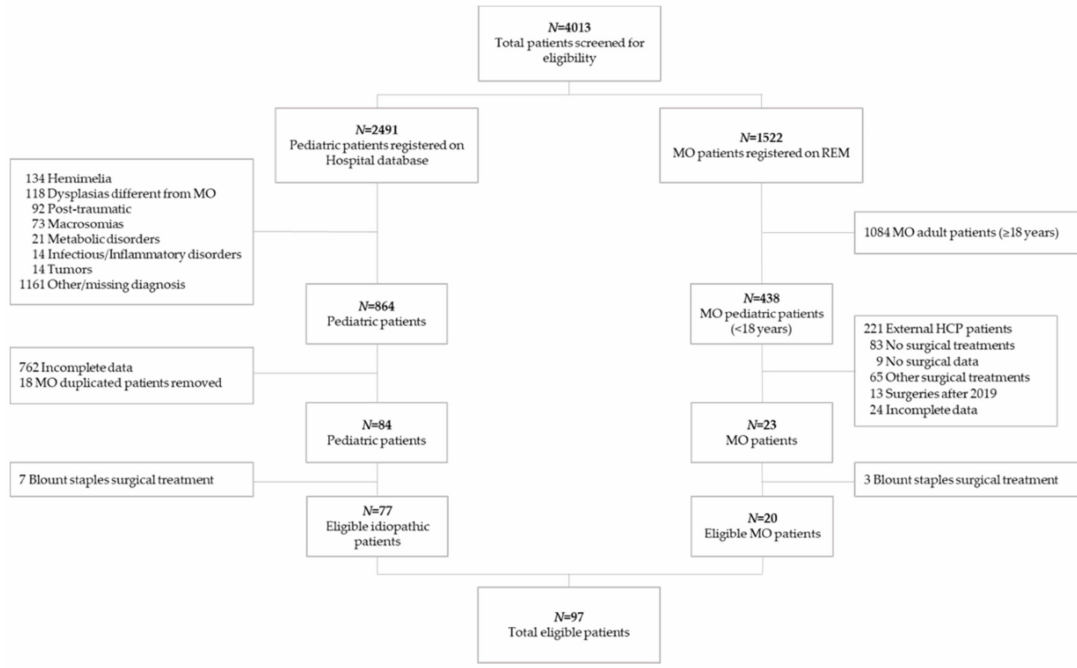
Figure 1. Flow chart of patients included in the study. REM: Registry of Multiple Osteochondromas. MO: multiple osteochondromas. HPC: healthcare provider (i.e., hospital, university,